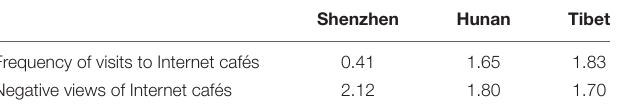
TABLE 1 | The first row reports quantified frequency of visits to wangba in the three regions—the higher the value, the more the students visit wangba on